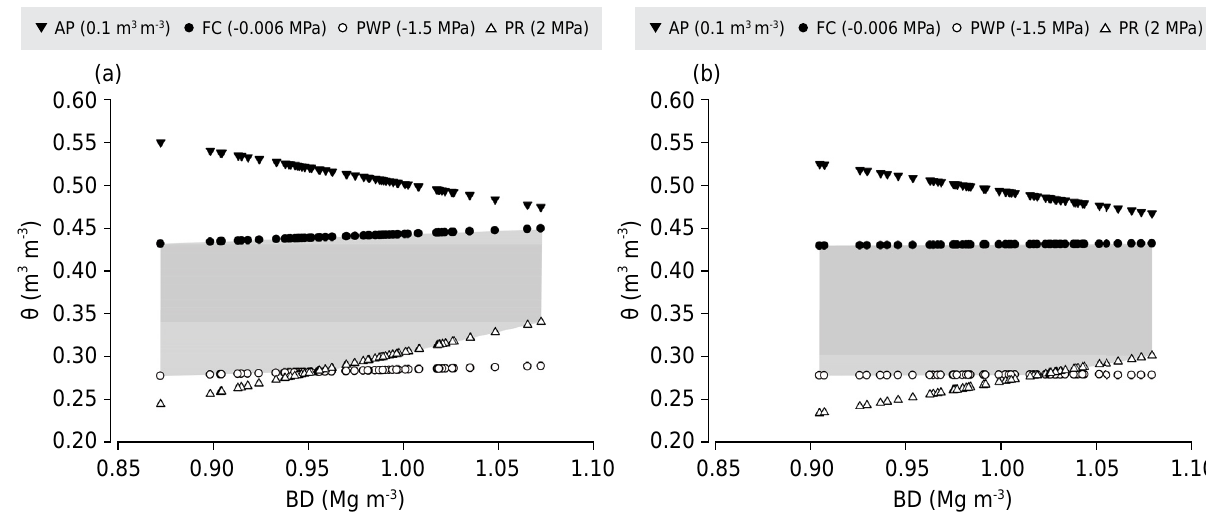
Figure 6. Water content (θ) with the variation of bulk density (BD) for field capacity (FC), permanent wilting point (PWP), aeration porosity (AP), and limiting penetration resistance (PR). The shaded area represents the LLWR. Surface liming (a) and incorporated liming (b).